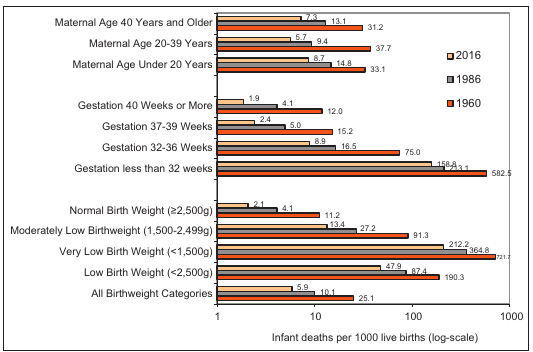
Figure 5 : Infant Mortality Rate by Maternal Age, Length of Ges - tation and Birthweight, United States, 1960-2016 Source: US National Vital Statistics System and National Linked Birth/Infant Death Data Sets, 1986 Birth Cohort and 2016 Period